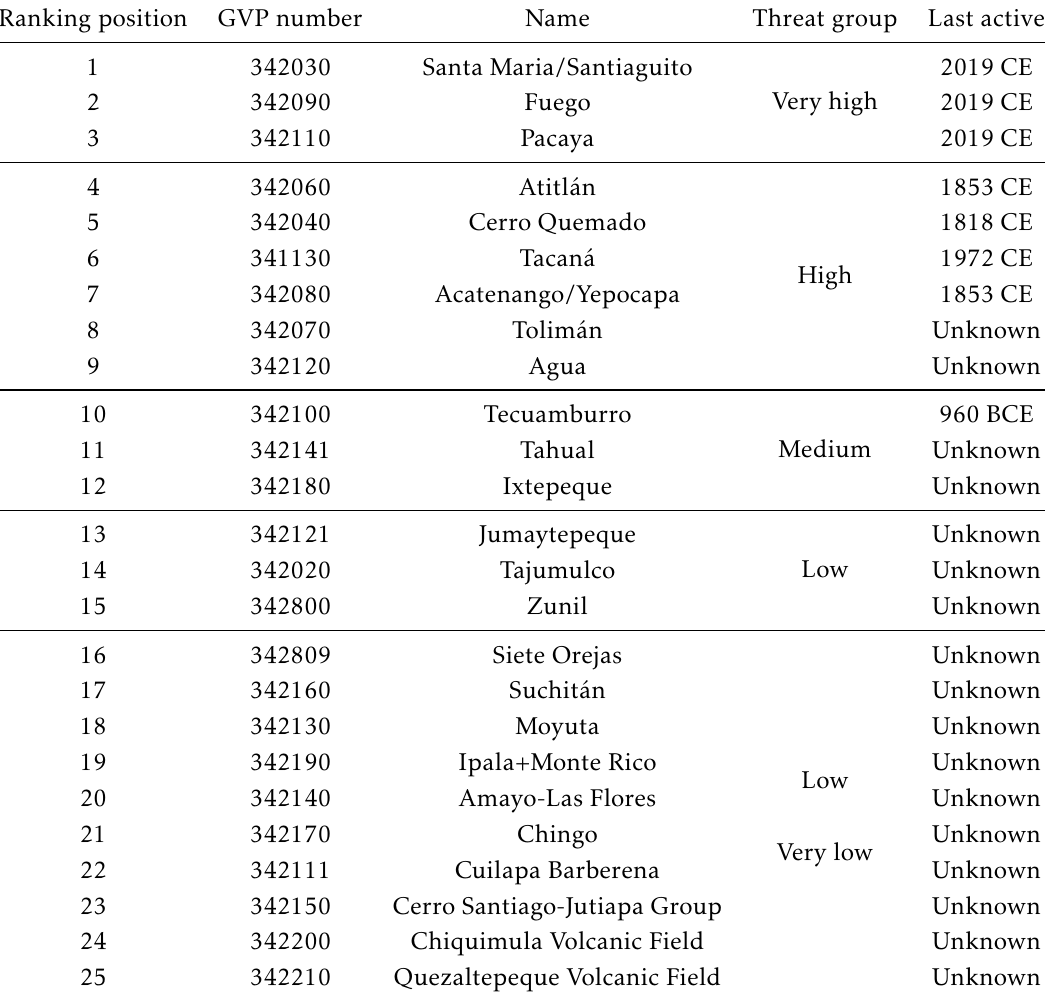
Table 1: Each volcano has an entry at the Smithsonian Global Volcanism Program website, with informa- tion about its geology, eruptive history, activity reports, and more (when available) that can be found at https://volcano.si.edu/volcano.cfm?vn= followed by the unique GVP Number as shown in the table. Ranking